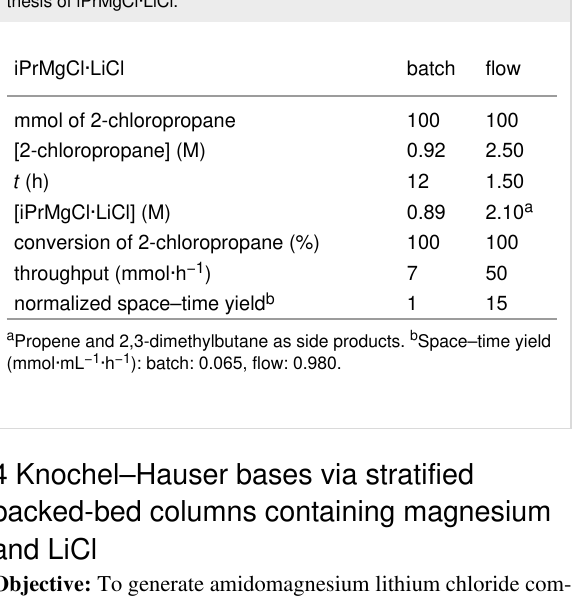
Table 3: Comparison of the batch [58] and flow conditions for the syn- thesis of iPrMgCl ⋅ LiCl.